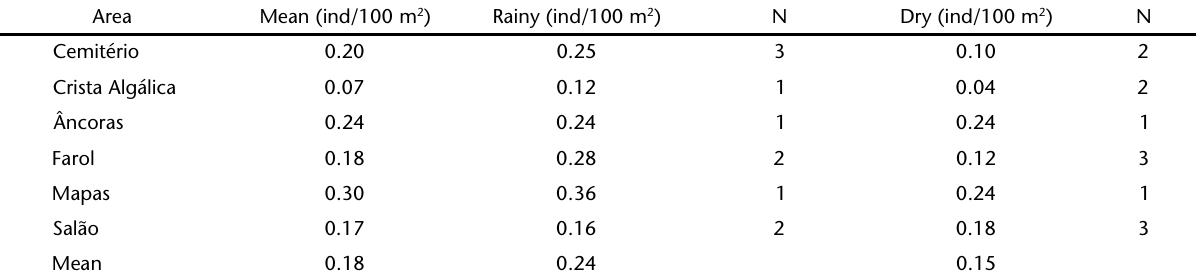
Table II. Mean density of O. insularis by sample area and by season of the year, between 2003 and 2008, in the Rocas Atoll Biological Reserve.